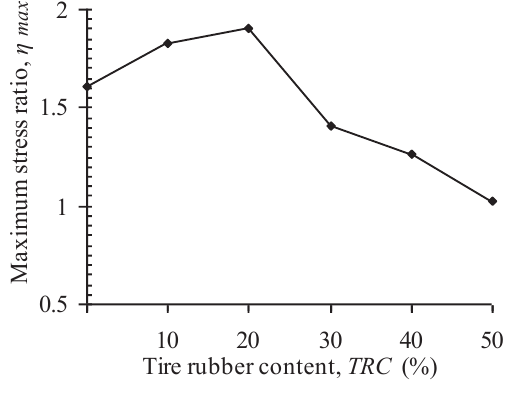
Fig. 3. Effect of rubber content on maximum stress ratio of mixtures Figure 3: Effect of rubber content on maximum stress ratio of mixtures.